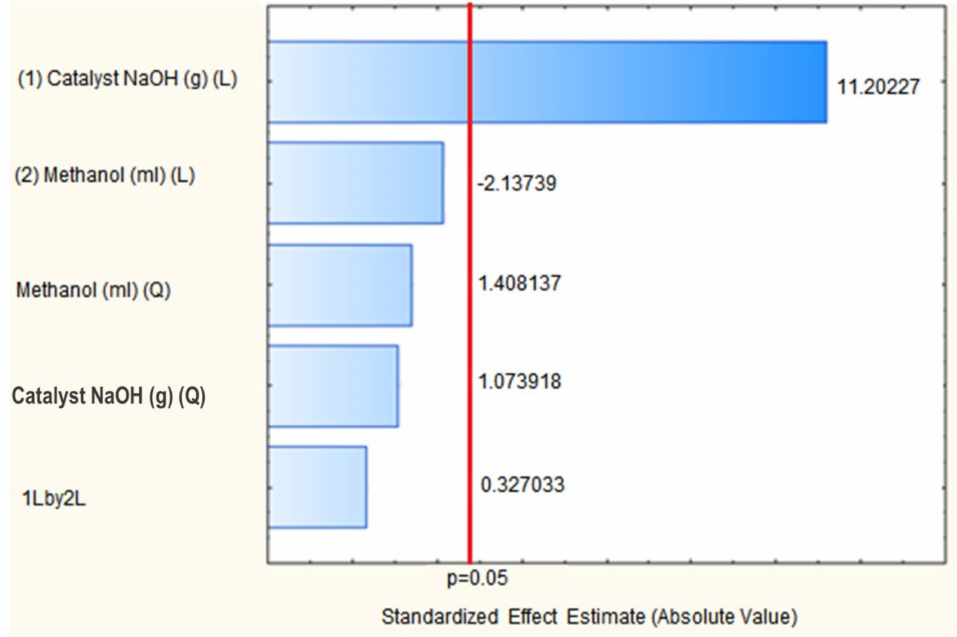
Figure 5. Pareto chart for the methyl transesterification reaction with a 95% confidence interval.